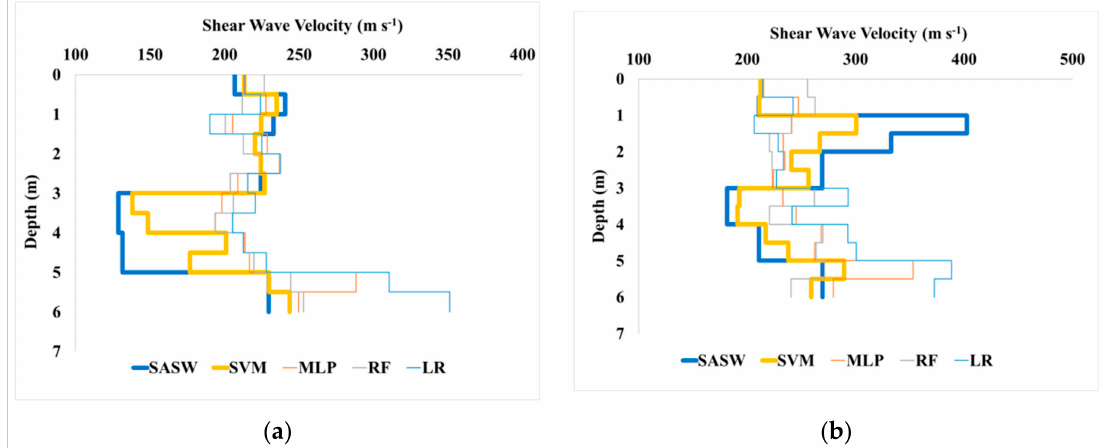
Figure 13. V S profiles from SASW inversion and ML algorithms for ( a ) test 1 and ( b ) test 2. Figure 14a illustrates that the V S from SVR was close to the SASW values and continued up to 6 m. The V S from SVR was consistent throughout the depth. Figure 14b also shows significant similarities up to 6 m, but from 2–3 m, SVR drifted from the V S from SASW.